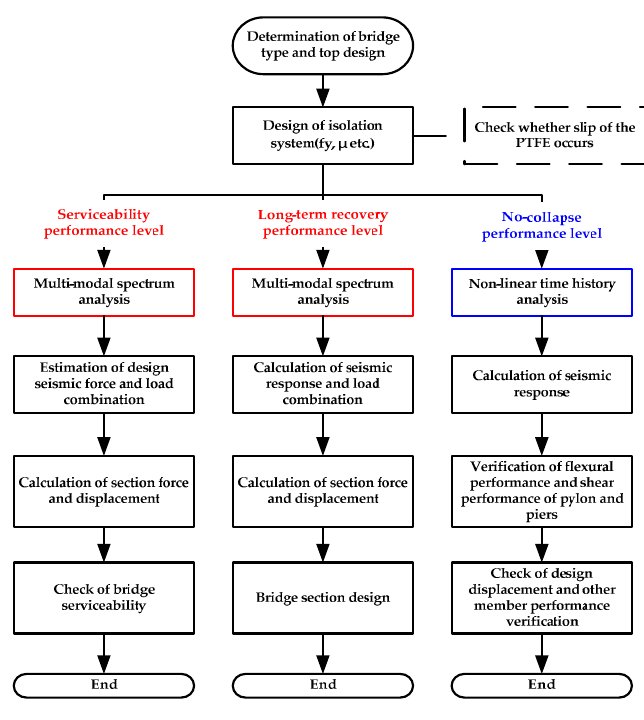
Figure A2. Proposed design procedure for R-FBI (Case II).